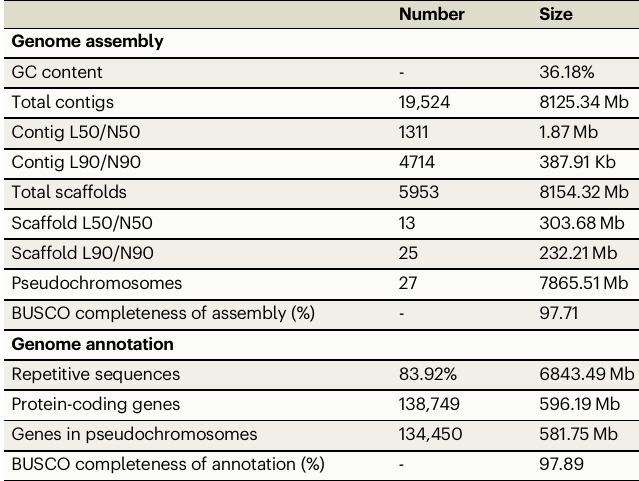
Table 1 | The statistics for genomeassembly and annotation of C.